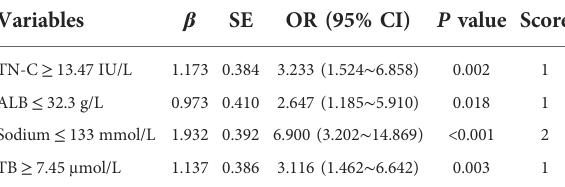
TABLE 2 Logistics regression analysis and the simple scoring system for predicting IVIG